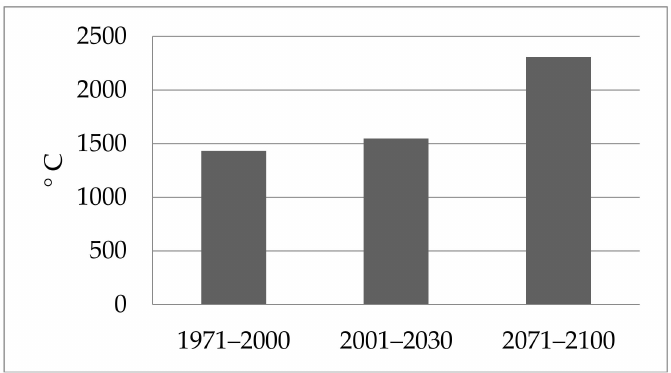
Figure 3. The sum of daily air temperatures above 10 ◦ C over the baseline period (1971–2000) and the projected climate scenarios (2001–2030 and